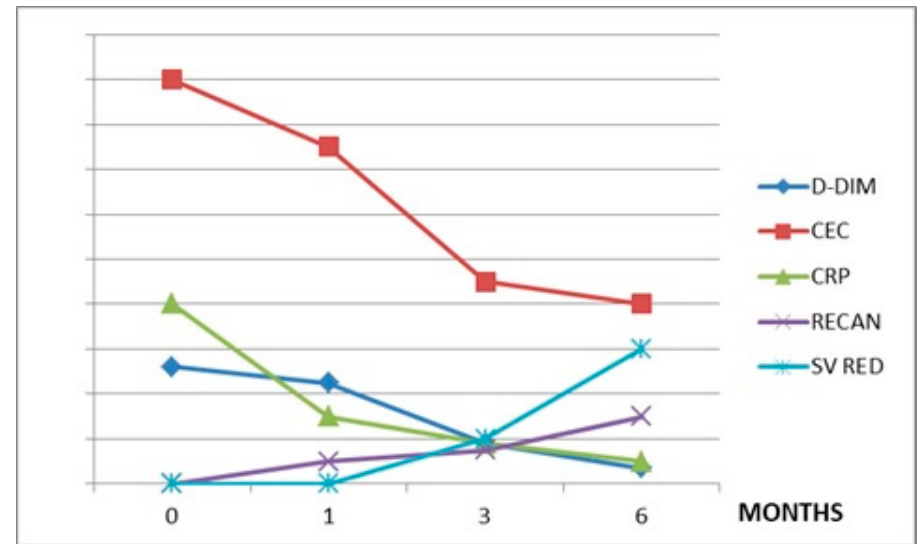
Figure 1. Ruxolitinib (A) group . CEC: circulating endothelial cells, CRP: C-reactive protein, D-DIM: d-dimers, RECAN: % of recanalization, SV: % of splenic volume reduction. Values on y-axis are in arbitrary measures.